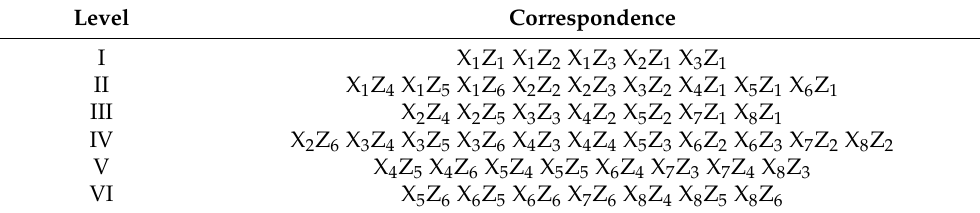
Table 10. Value Evaluation Form.